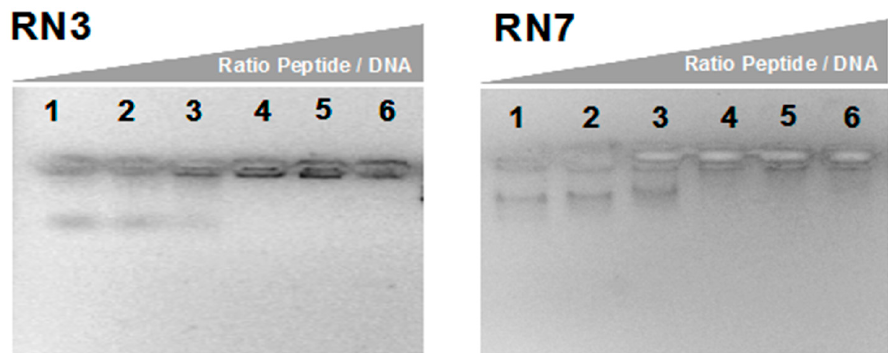
Figure 3. Gel retardation assay. Binding DNA was assayed by the inhibitory effect of peptides on migration of DNA. Different amounts of peptides were incubated with 200 ng of pET 28a plasmid DNA in 10 μ L of binding buffer at room temperature during 20 min and subjected to electrophoresis on a 1.0% agarose gel. The first lane corresponds to negative control without peptide and the following lanes correspond to weight ratios peptide/DNA 2.5:1, 5:1, 10:1, 20:1 and 50:1 respectively.